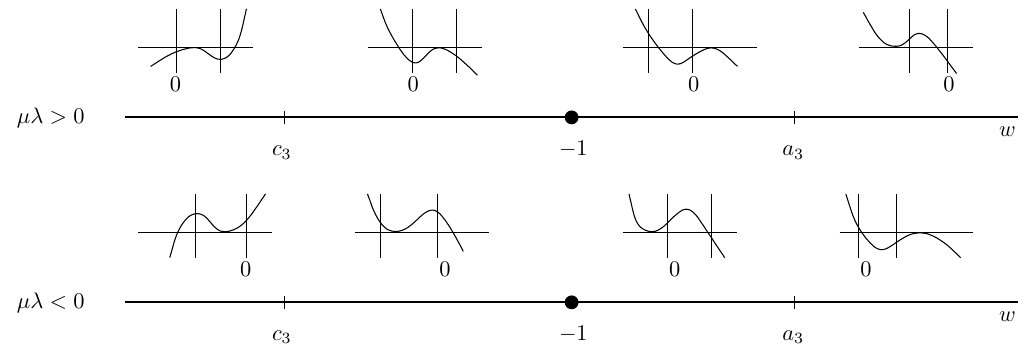
Figure 23. Pro(cid:12)le of the function U ( (cid:0) ; +) 1 . The vertical line in each potential plot with label 0 denotes the point (cid:27) = 0 and the unlabelled vertical line is the point (cid:27) = (cid:0) (cid:22)